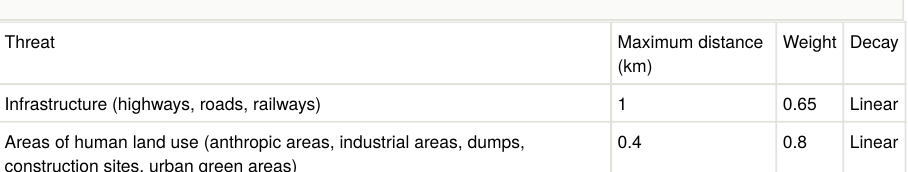
Table 1. Threats used as input for habitat quality and parameter values used to parameterise the InVEST